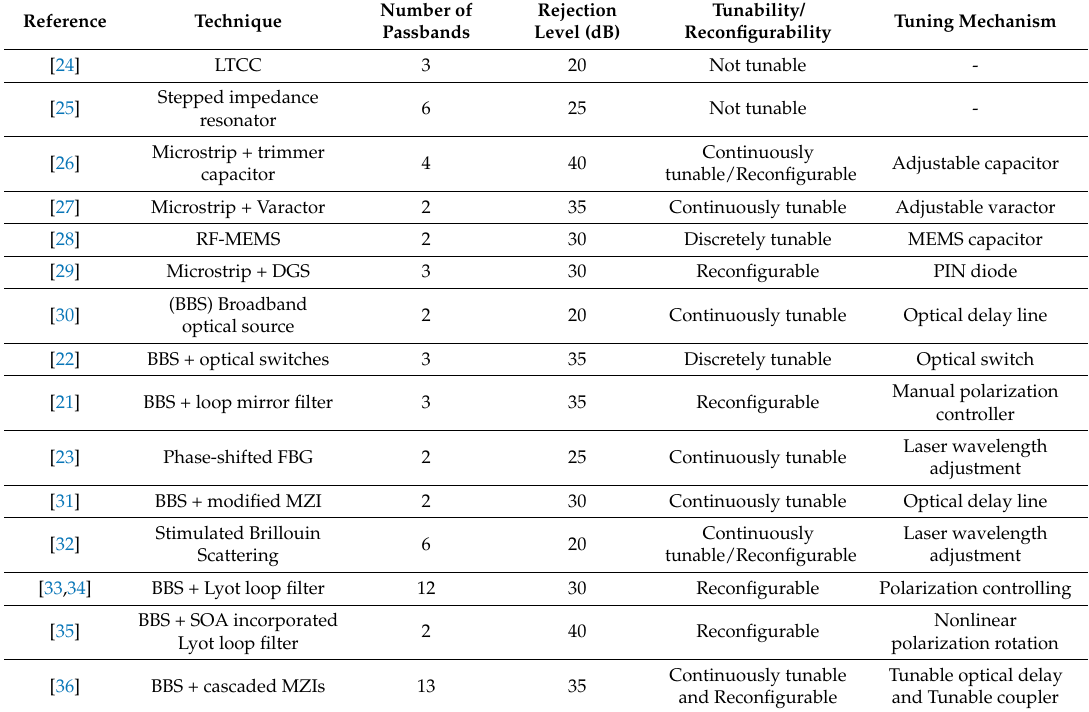
Table 1. Comparison of the Tuning Mechanism of the State-of-the-Art Multiband RF Filters.